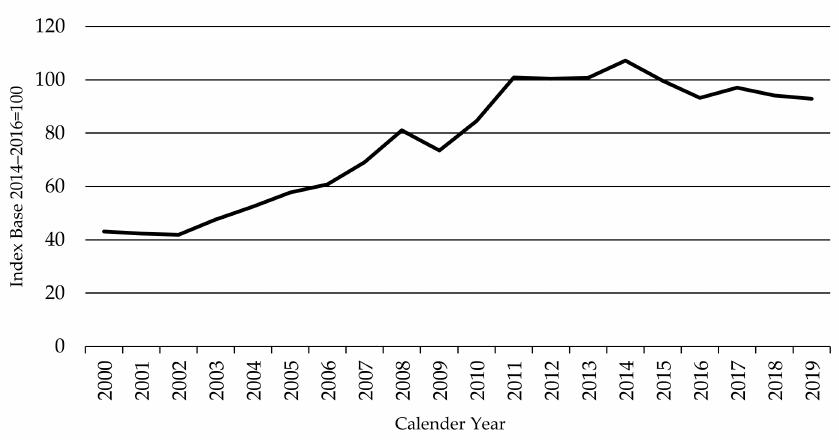
Figure 1. The Global Finished Cattle Producer Price Index FPPI, source: own